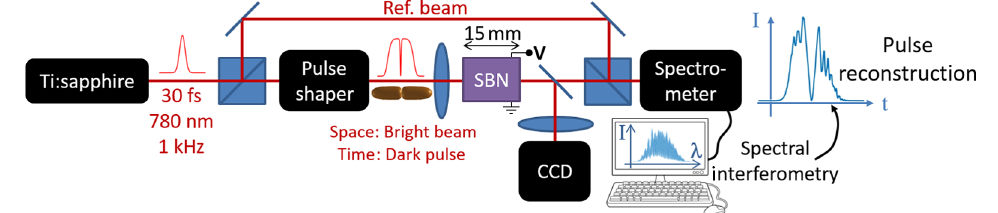
FIG. 1. Experimental setup. ATi:sapphire laser pulse-train beam ( λ ¼ 0 . 8 μ m) with 1-KHz repetition rate and 30-fs pulse duration is divided into reference and signal beams. The signal beam propagates through a pulse shaper designed to form a dark pulse (100-fs FWHM) centered at a relatively wide background pulse (1-ps FWHM). The dark pulse-train beam is then focused to the input face of a photorefractive SBN crystal ( 5 × 5 × 15 mm and 6 × 6 × 6 mm). The spatial intensity distributions at the input and output faces of the crystal are recorded by an imaging system and CCD. The temporal pulse profile is characterized through spectral interferometry by interfering the reference and signal beams in a spectrometer.